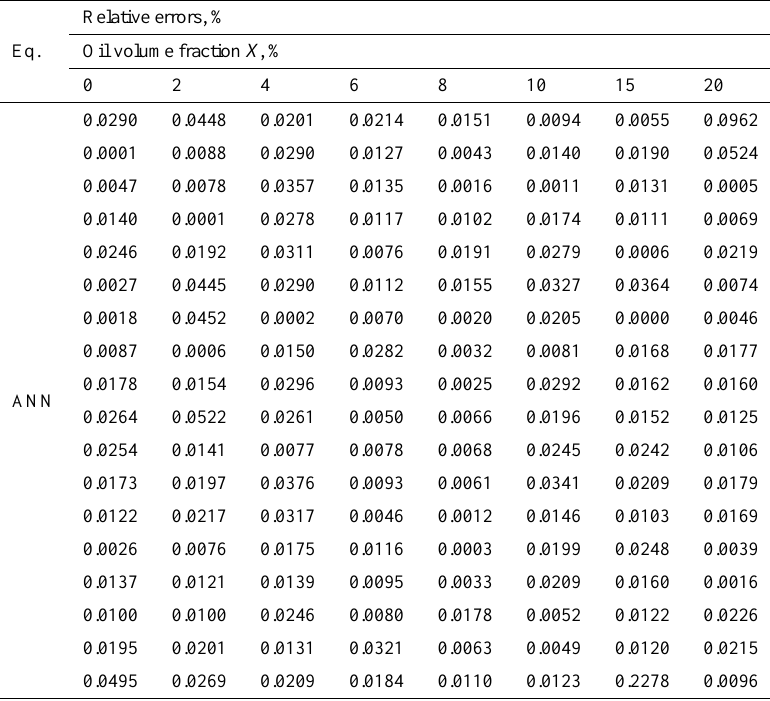
agreement with the experimental results in terms of qualitative goodness of fit. However, ANN cannot represent closely the relationship between density and temperature because of insufficient experimental measurements data in [25] mentioned above. The computed values illustrated as lines in Fig. 6 and [35, Fig. 33–45] were forced by ANN to exactly pass the experimental data [25], like the variation in viscosity mentioned above as depicted in Fig. 3 and Fig. 4 and [35, Fig. 8–25]. Therefore, some relative errors in the measurement points computing from ANN are much lower than the rational model. [35, Table 1] presents measured density data given by Nogueira et al. [25] for different temperatures (293.15–373.15 K), percent relative errors coming from the exponential and linear models and ANN, and regression constants and correlation coefficients of these models. The lowest R values of the exponential and linear models were determined as 0.9998 and 0.9997, respectively, while the highest relative errors were determined as 0.0813 %, 0.0919 % and 0.2409 % for Eq. (5) and Eq. (6) and ANN. According to these results, the best match to the density values of ternary blends measured by Nogueira et al. [25] is obtained using the exponential model in terms of quantitative goodness of